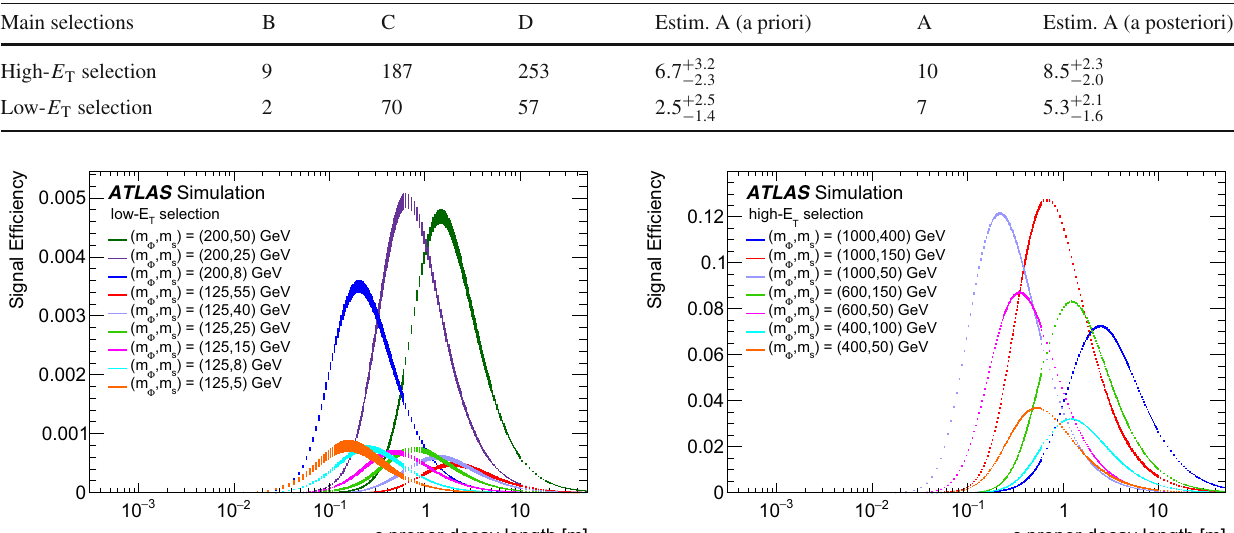
Table 3 Application of the modified ABCD method to the final high- E T and low- E T selections. The columns A, B, C and D contain the number of observed events in each region. “Estim. A” refers to the esti- mated contribution of background in the search region A assuming no signal, as calculated using the full statistical model decribed in Sect. 7. The a priori estimate refers to the “pre-unblinding” case, where the data inregionAareignoredbyremovingthePoissonconstraintinthatregion